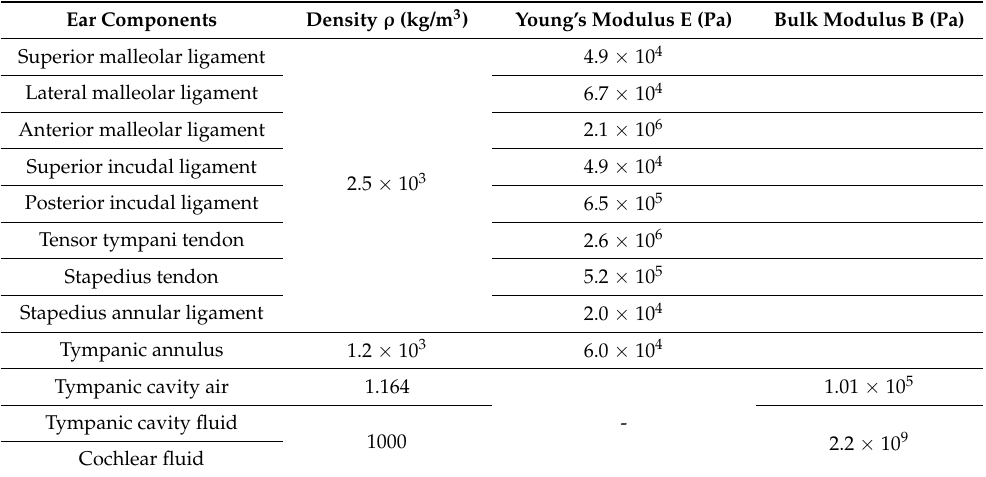
Table 2. Material properties of the ligaments, muscles and acoustic medium